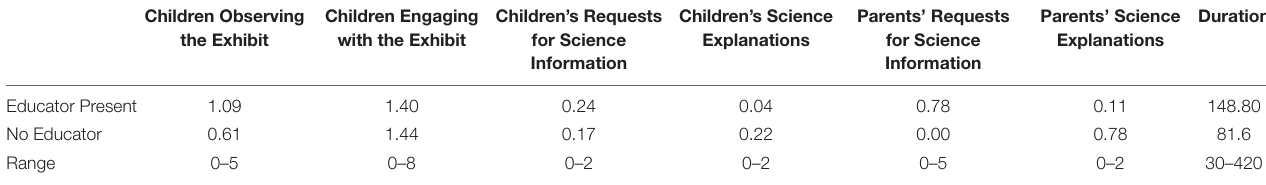
TABLE 4 | Means and ranges for children’s and parents’ behaviors when an educator was present or not.